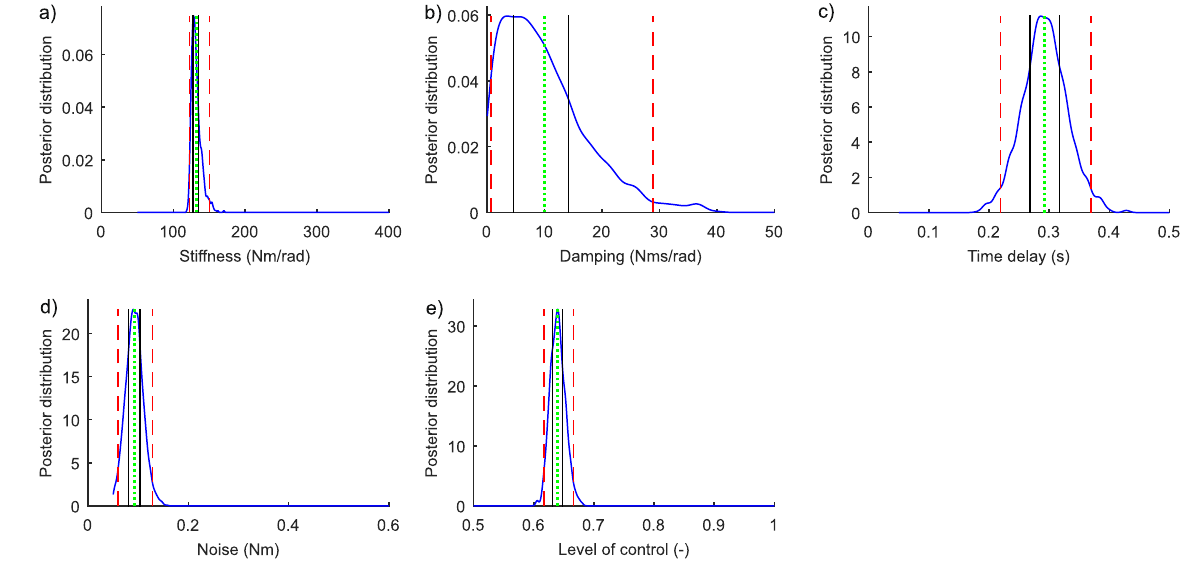
Figure 8. Marginal posterior probability density functions for the five parameters (real subject, same one as in Fig. 7, mid panel): ( a ) Stiffness, P ; ( b ) Damping, D ; ( c ) Time delay, Δ ; ( d ) Noise, σ ; and ( e ) Level of control, C ON . Vertical lines present estimated parameter values (green, dotted), 50% CIs (black, solid), and 95% CIs (red, dashed). The ranges on the x-axes correspond to the ranges of the prior distribution.